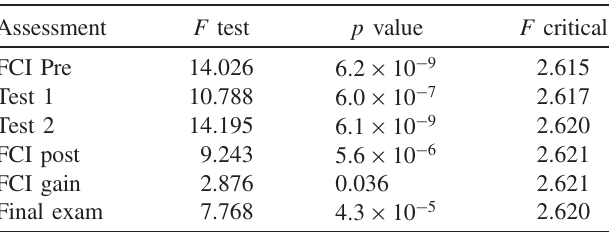
TABLE XII. One-way analysis of variance